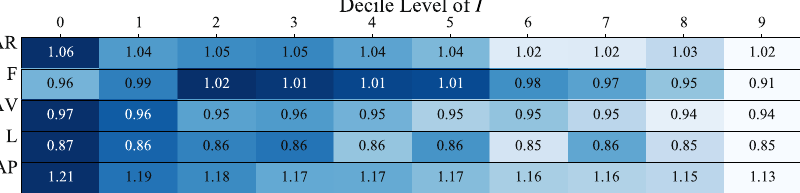
Fig. 4 Average UCS prediction (BSIF model) of lot image intensity decile groups for fi ve randomly sampled lots. The color scheme is determined within each row (or sample lot) and high prediction corresponds to dark color. It can be seen that the left side is generally darker than the right side, meaning that darker images generally correspond to higher UCS predictions.